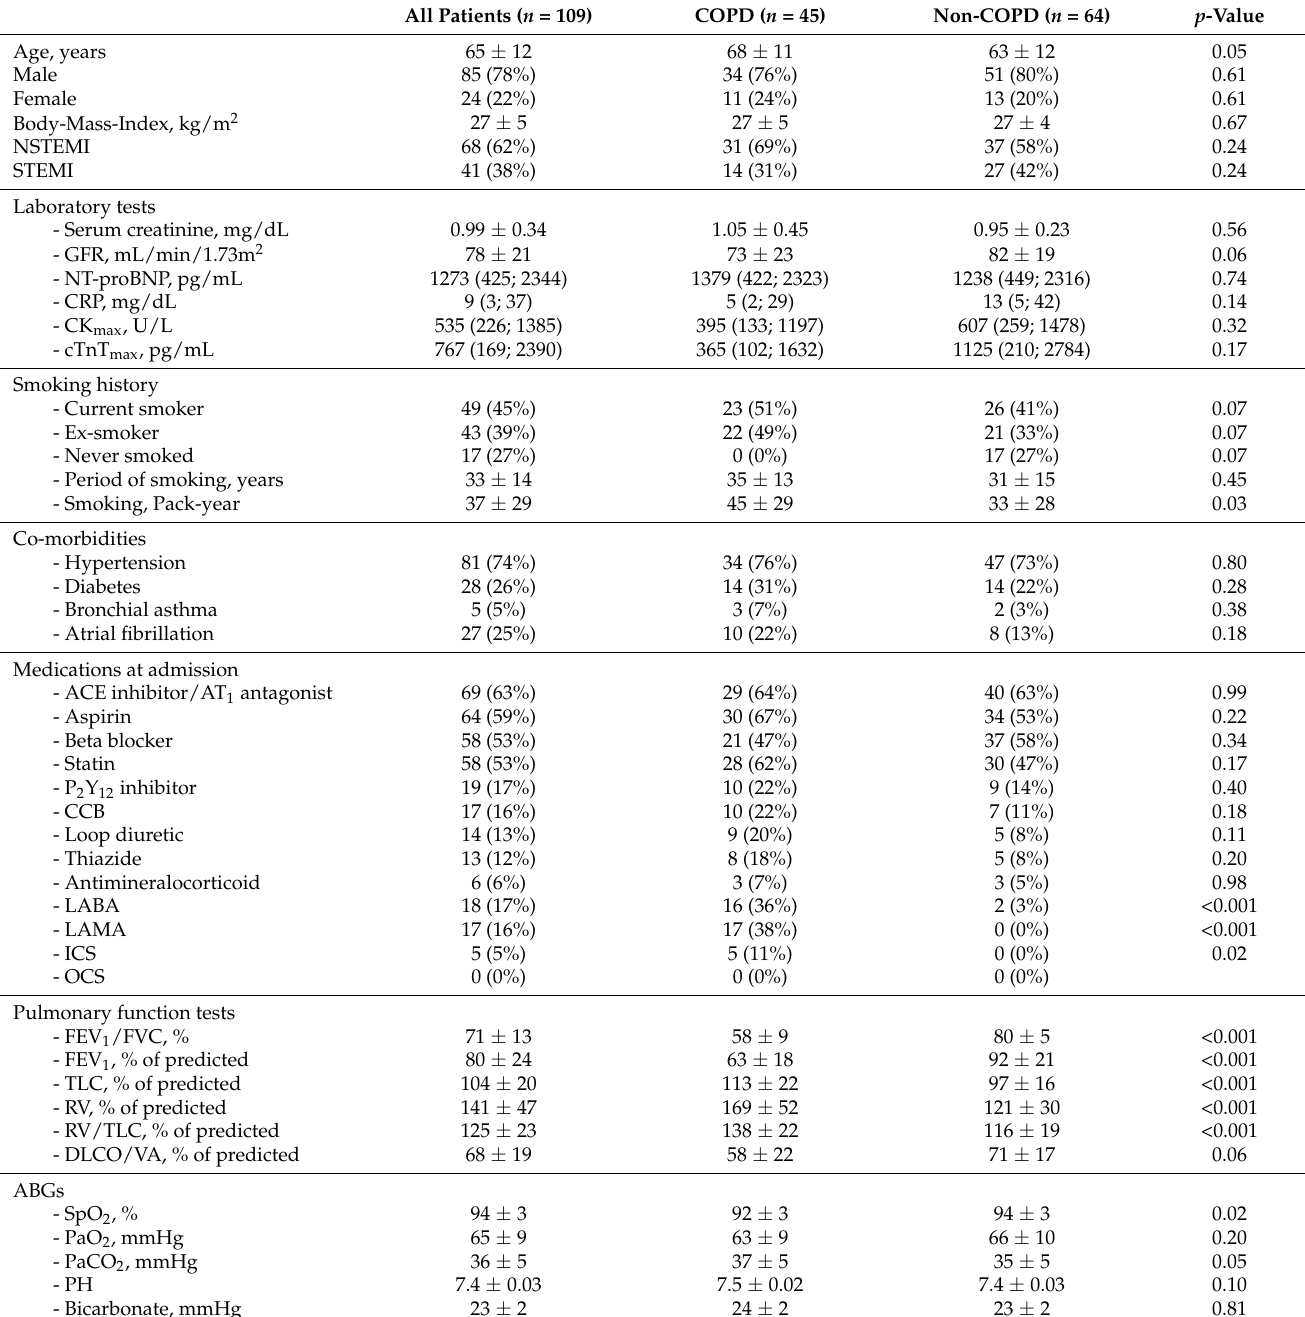
Table 1. Patients’ clinical and demographic